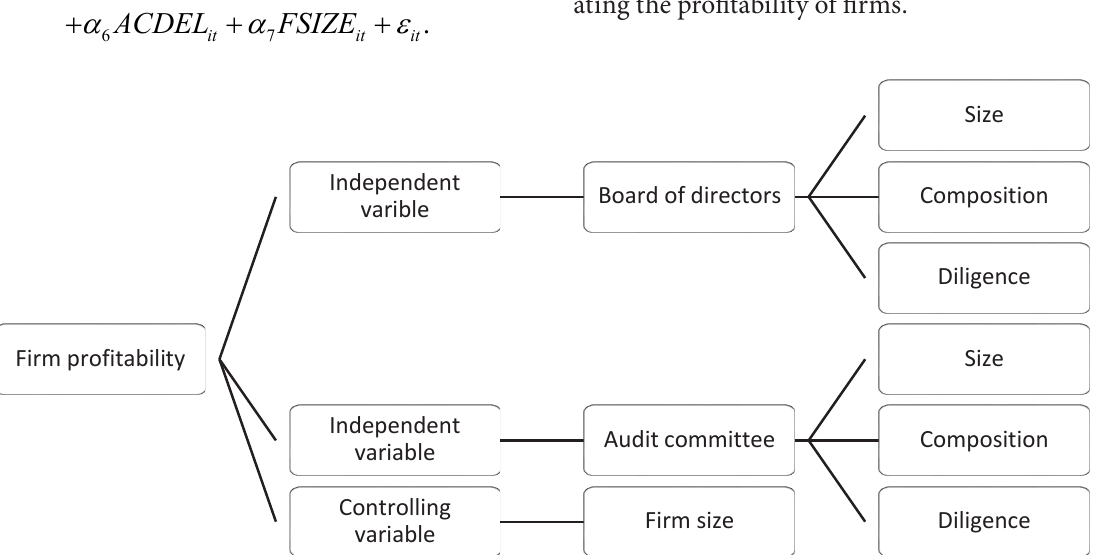
Figure 1. Study framework for all